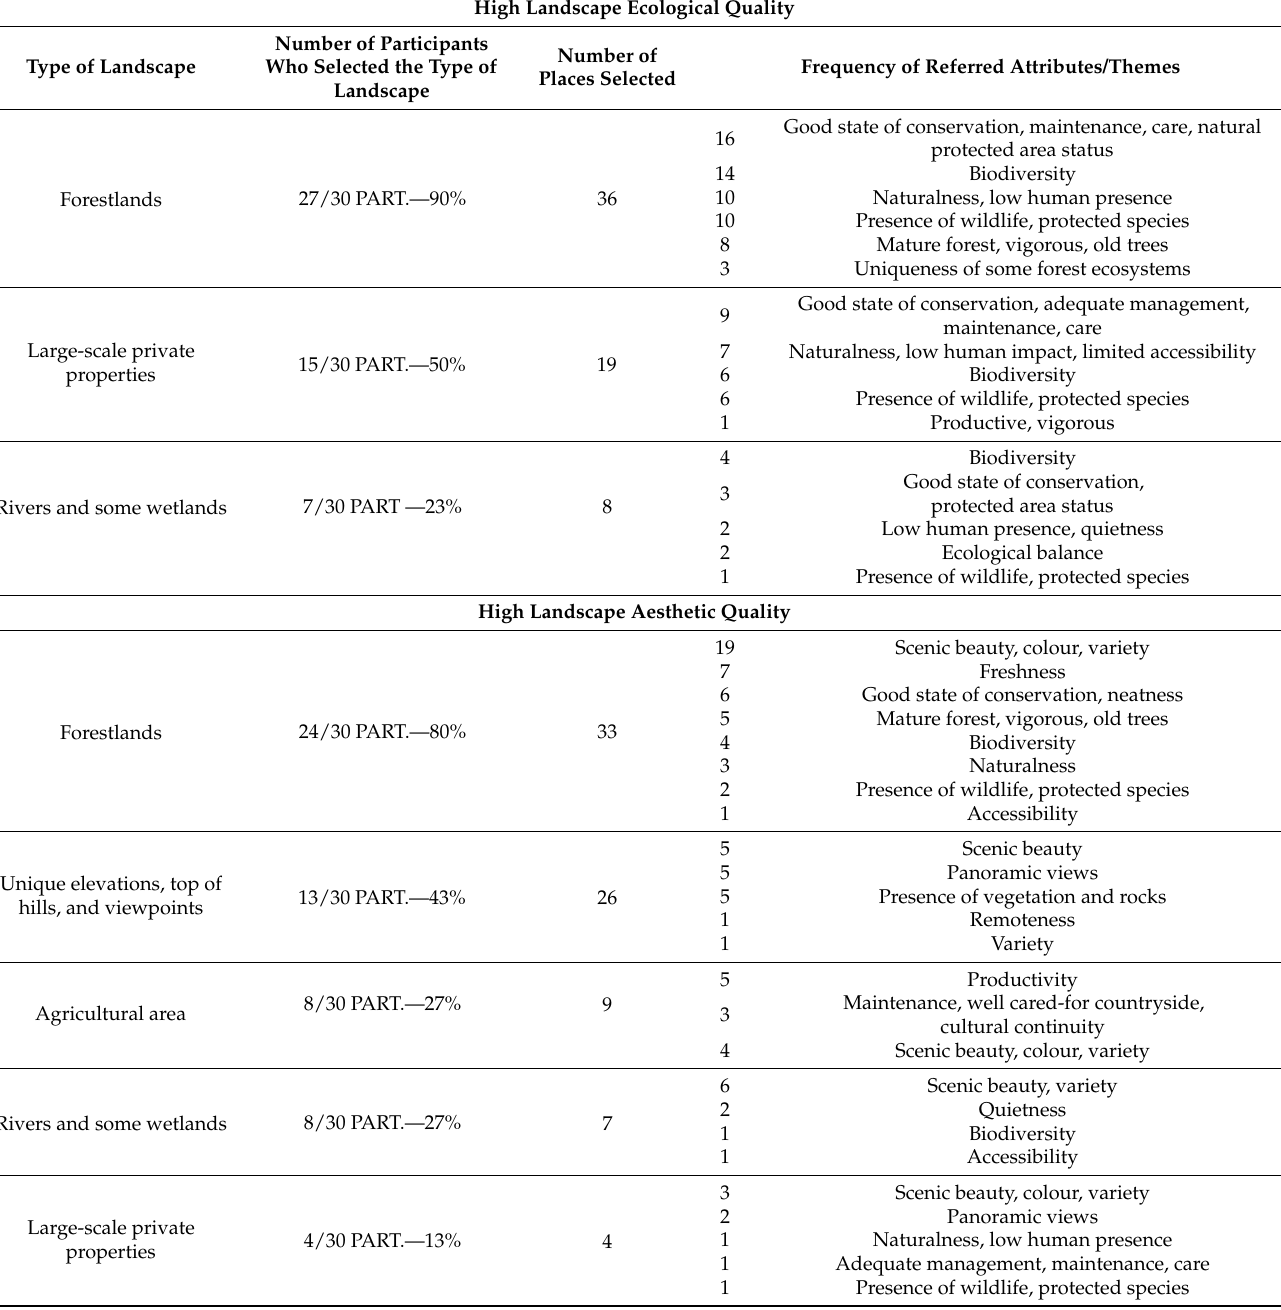
Table 2. Summary of the